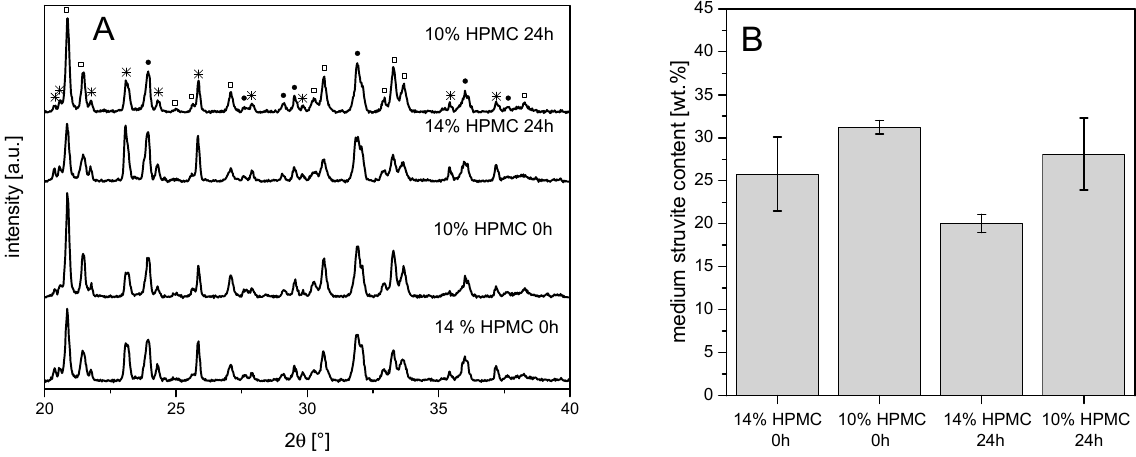
Figure 4. ( A ) X-ray diffraction patterns and ( B ) struvite content of Mg 2.25 Ca 0.75 (PO 4 ) 2 magnesium phosphate cement pastes with different powder to liquid ratios (14% ≙ PLR 1.93; 10% ≙ PLR 1.35) after 0 and 24 h storage of the paste at 37 °C prior to hardening; □ : struvite, ● : stan fi eldite, * : farringtonite.